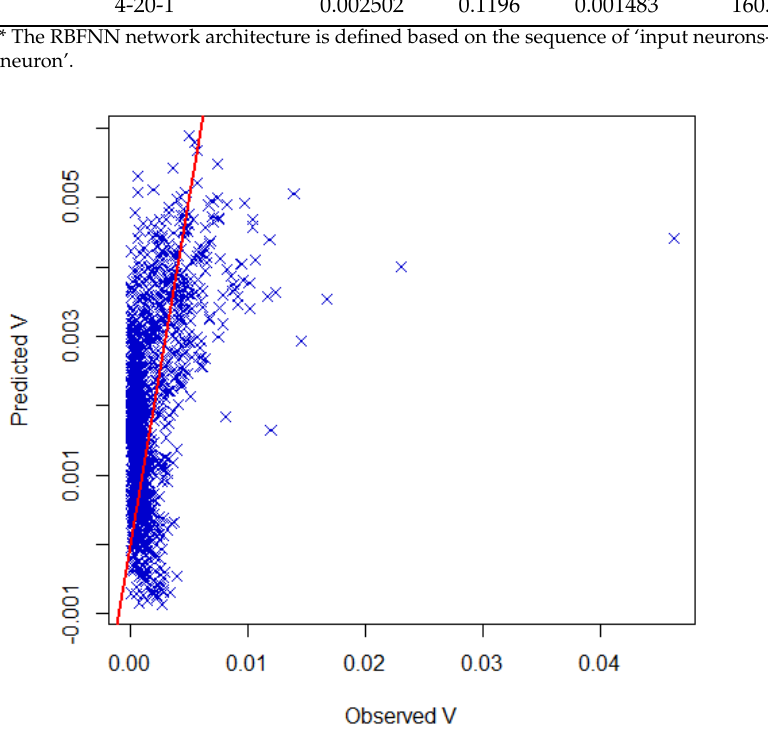
Figure 6. Comparison plot of predicted and observed settling velocity for the RBFNN model with network architecture 4-16-1.